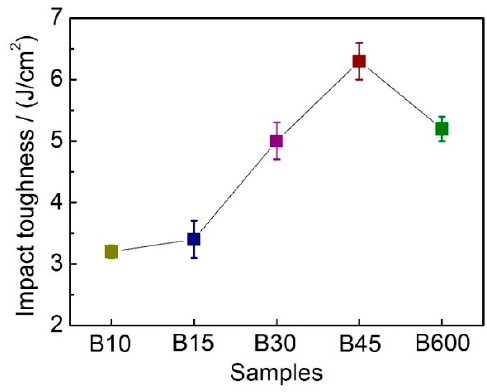
Figure 3. Impact toughness values of the studied steel.